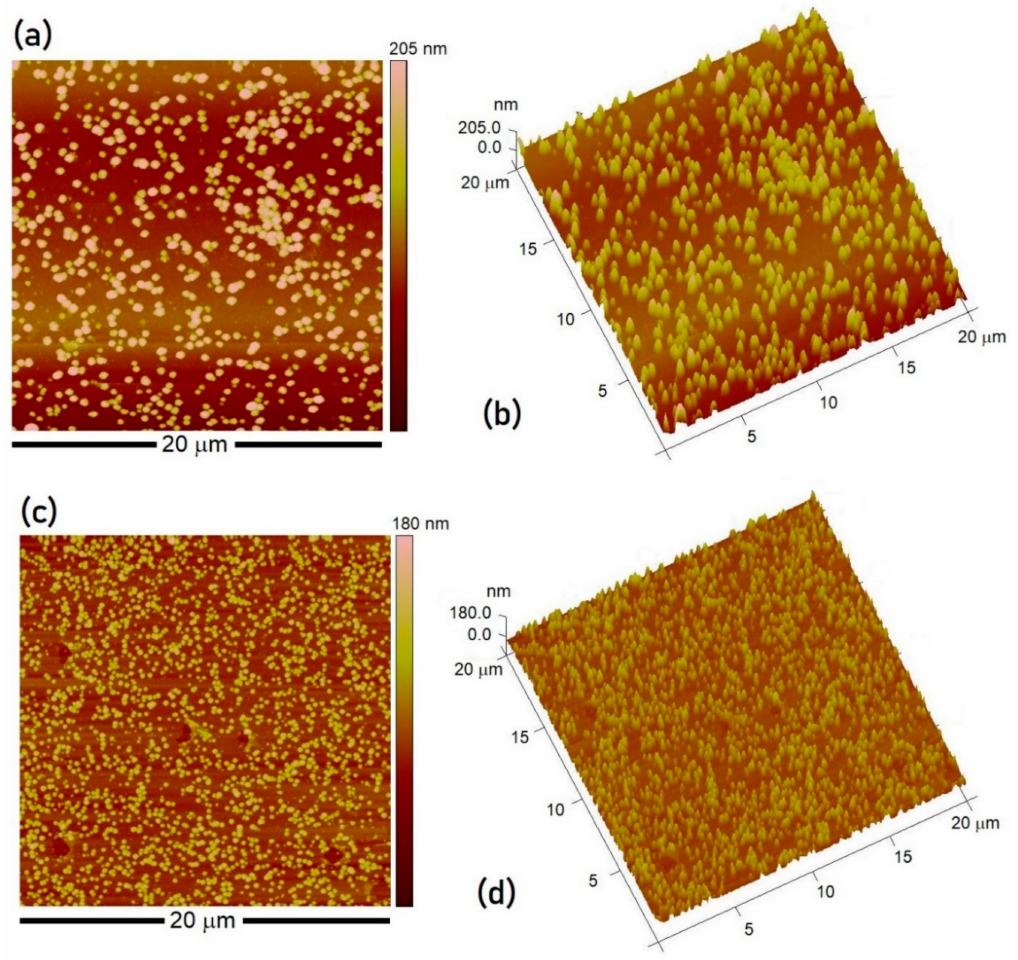
Figure 4. The 20 µ m area scans showing AFM images and the 3-D topography of the Nafion supported Co-based nanoparticles after 20 s EC reduction (S 4 vs. S 5 , Table 1): ( a , b ) Co 2+ immersion followed by EC reduction (IR, S 4 ) and ( c , d ) direct EC reduction in the CoSO 4 +H 3 BO 3 solution (DR, S 5